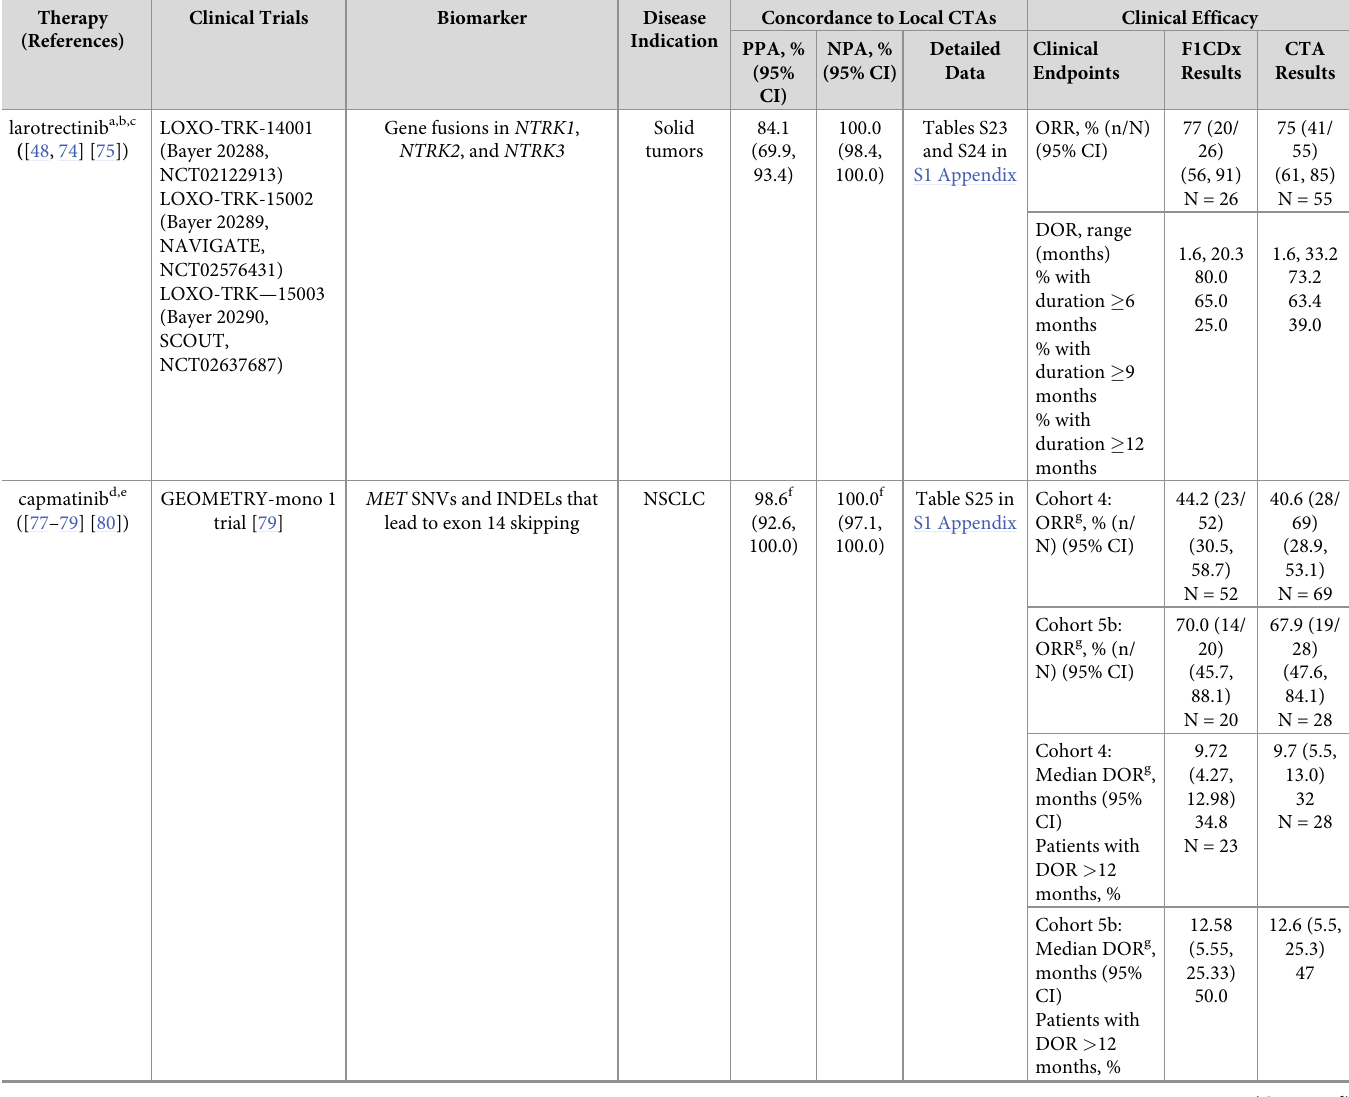
Table 3. Clinical utility of F1CDx in each efficacy analysis population.